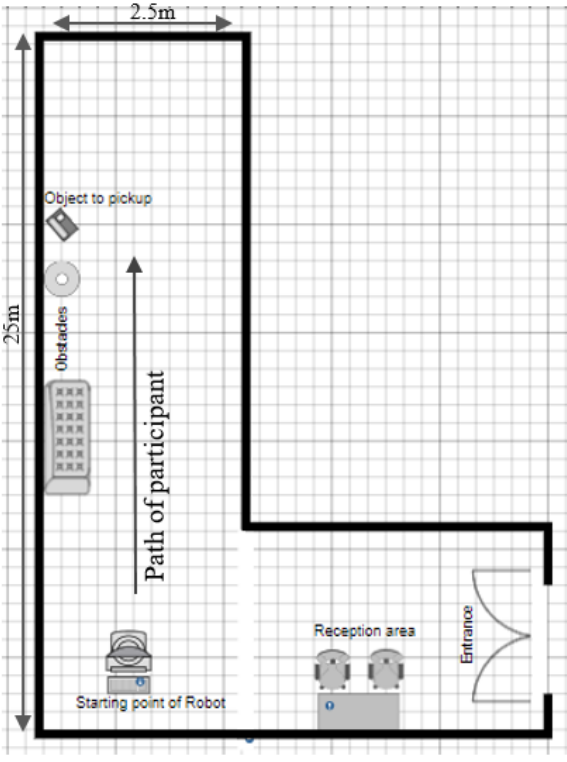
Figure 2: Map of the environment in which experiments were per- formed.